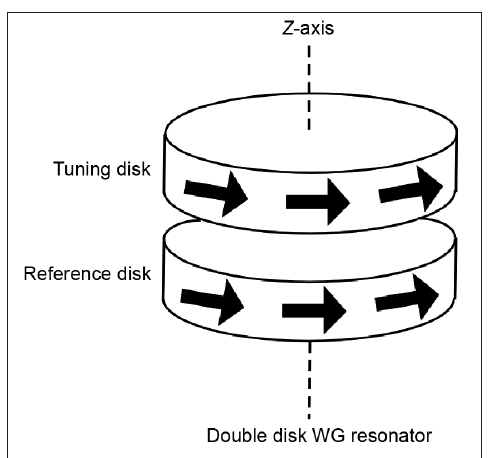
Fig. 4. Sketch of a double-disk Whispering Gallery (WG) microwave